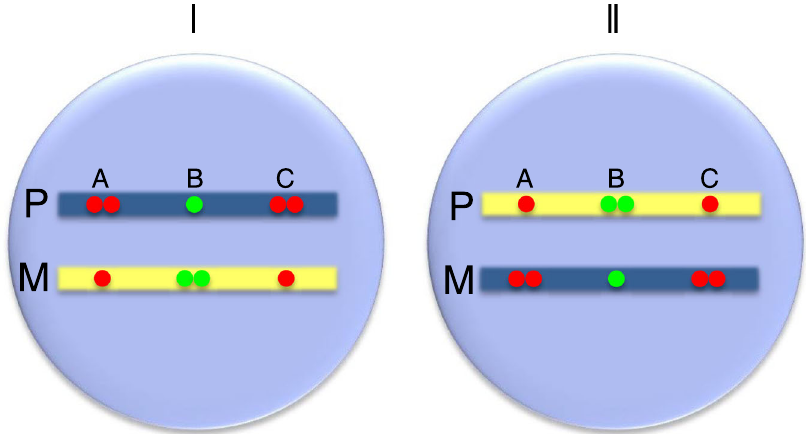
Fig. 6 Orientation of asynchronous regions. All cells are in one of two states (I or II), Paternal (P, blue), Maternal (M, yellow). Probes A and C replicate in a parallel manner, with both being early on the same allele, while probes A and B always replicate in an antiparallel manner both in cell I and